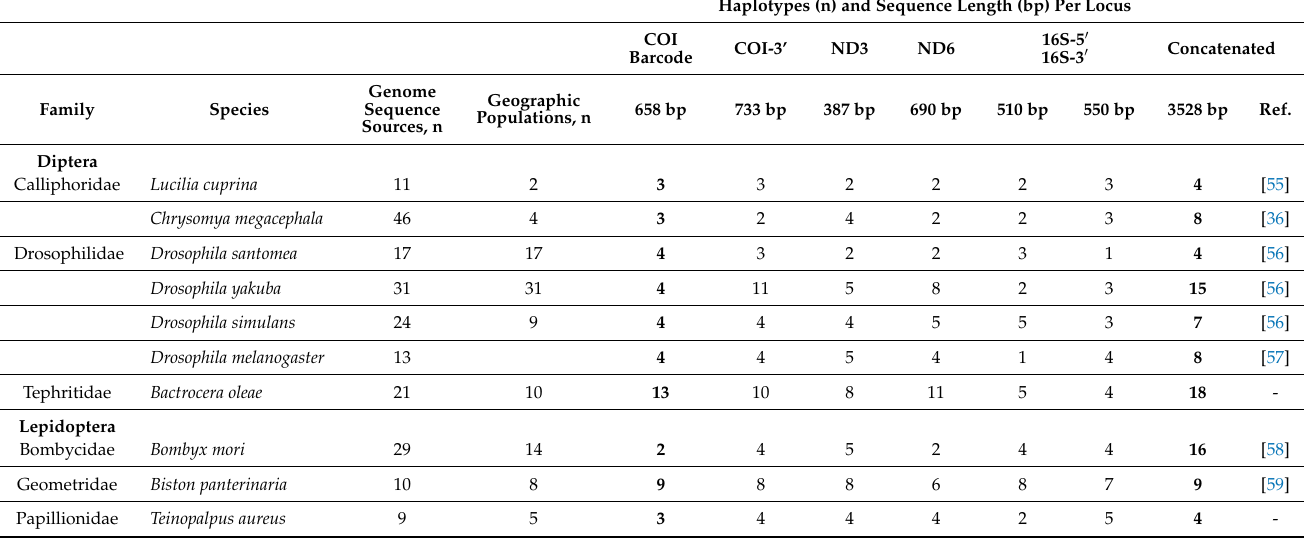
Table 1. Haplotypes observed in-silico at six genes from Diptera and Lepidoptera mitochondrial genome population data available in GenBank, with the bold emphasising difference between the haplotypes achieved with COI barcode and concatenated loci.